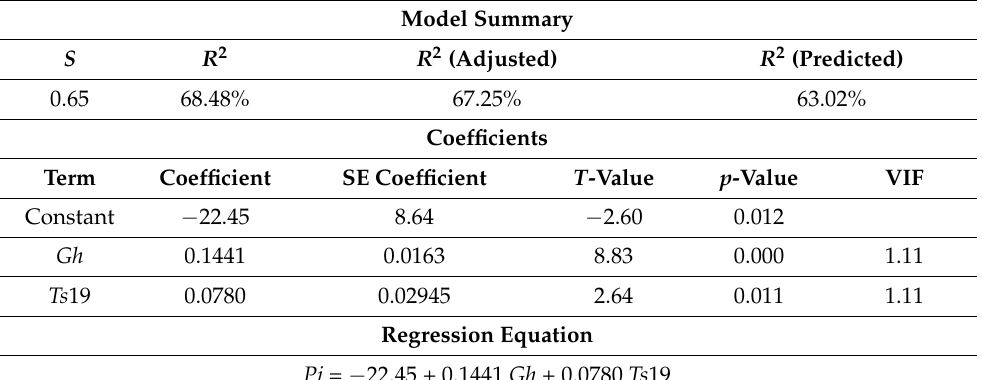
Table 6. Model summary for mod-still (Model